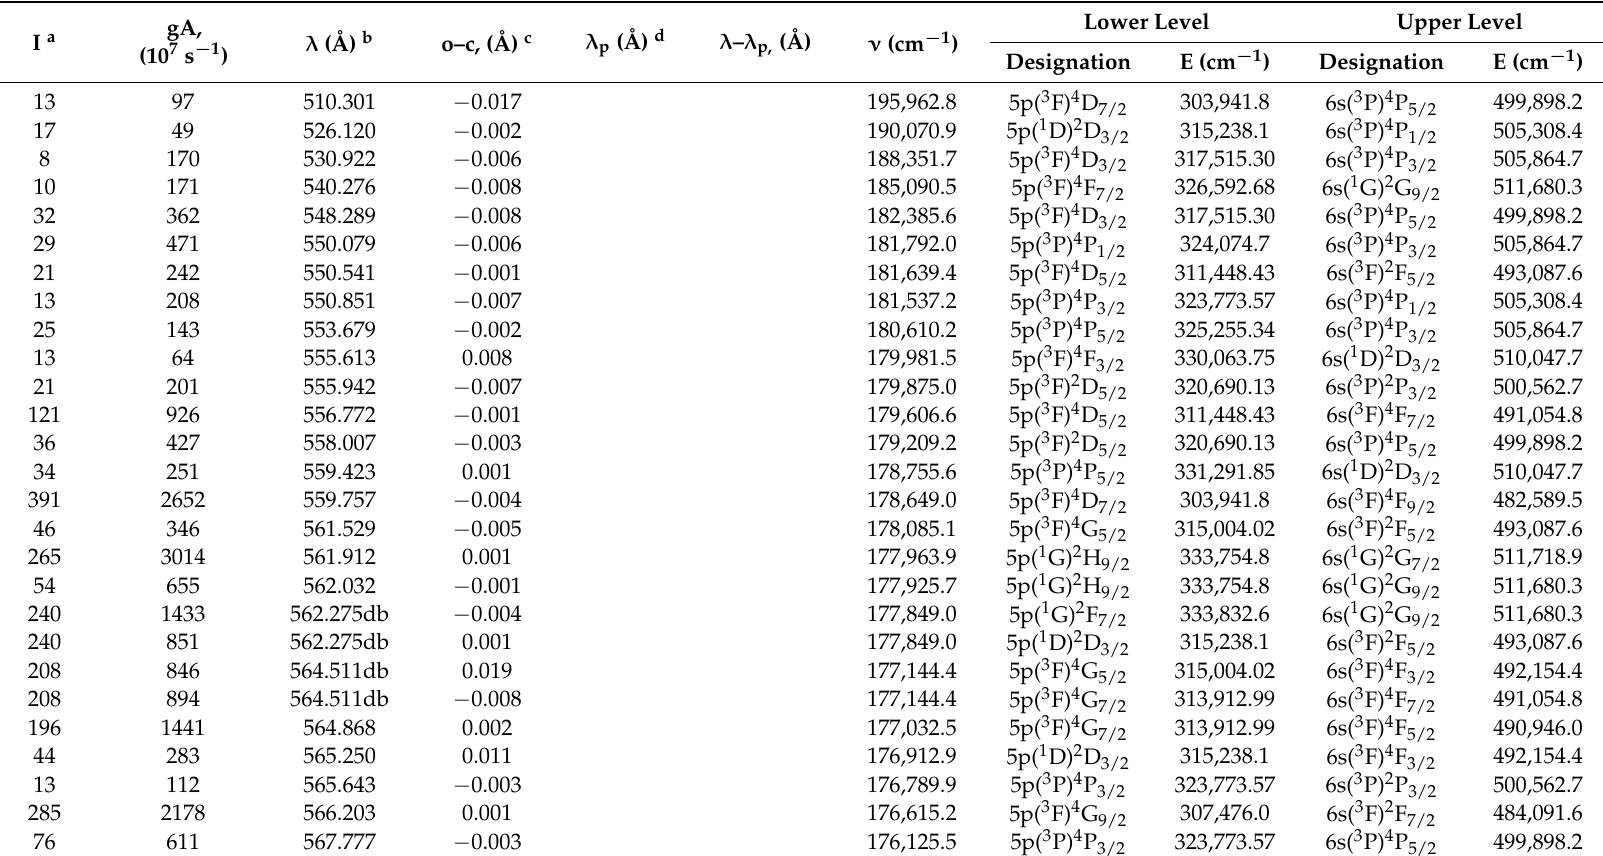
Table A1. Identified lines of the transitions between 4d 8 5s, 4d 8 6s, 4d 8 5p and 4d 8 5d configurations in the spectrum of Sn 5+